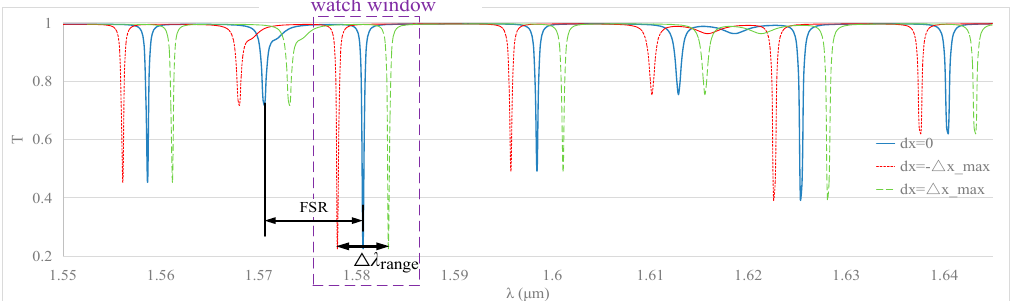
Figure 13 . Transmission spectra drift of the MOEMS gyroscope. Figure 13. Transmission spectra drift of the MOEMS